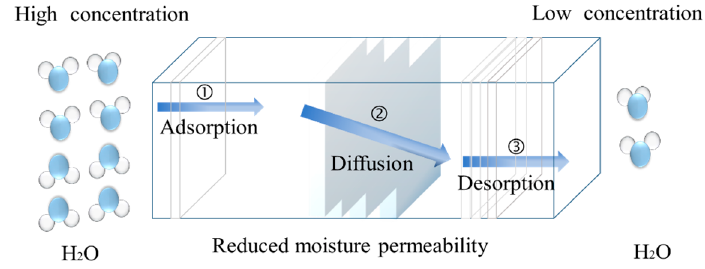
Figure 1. Schematic representation of the moisture uptake.